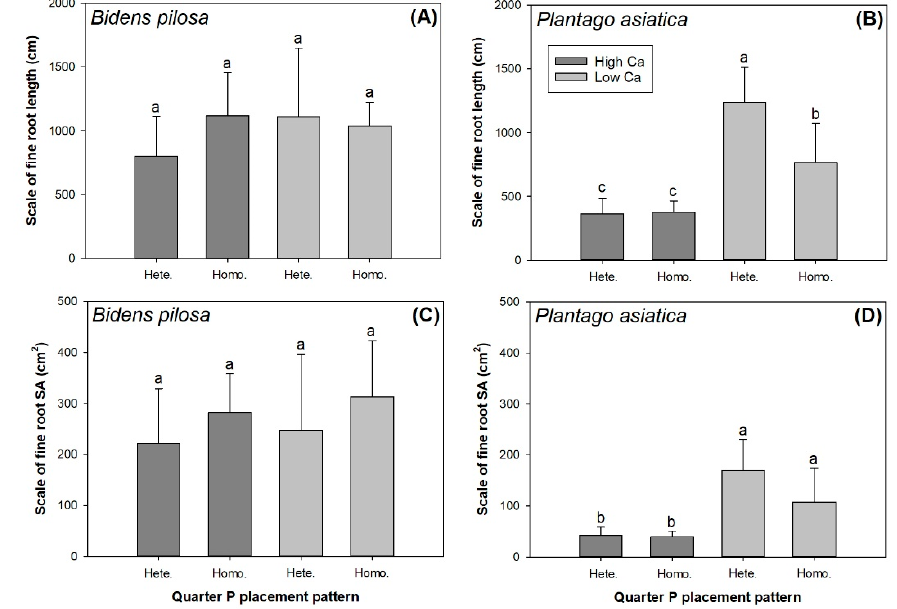
Figure 3. Fine root foraging behavior gauged as length ( A , B ) and surface area (SA) ( C , D ) in Bidens pilosa and Plantago asiatica plants subjected to phosphorus (P) input as heterogeneous (Hete.) and homogeneous patterns (Homo.) at high calcium (Ca) (2 g kg − 1 ) and low Ca levels (0.63 g kg − 1 ). Error bars stand for standard errors. Same letters in a cell of figure indicate the failure to find significant difference by Duncan’s new multiple range test at the p < 0.05 level.